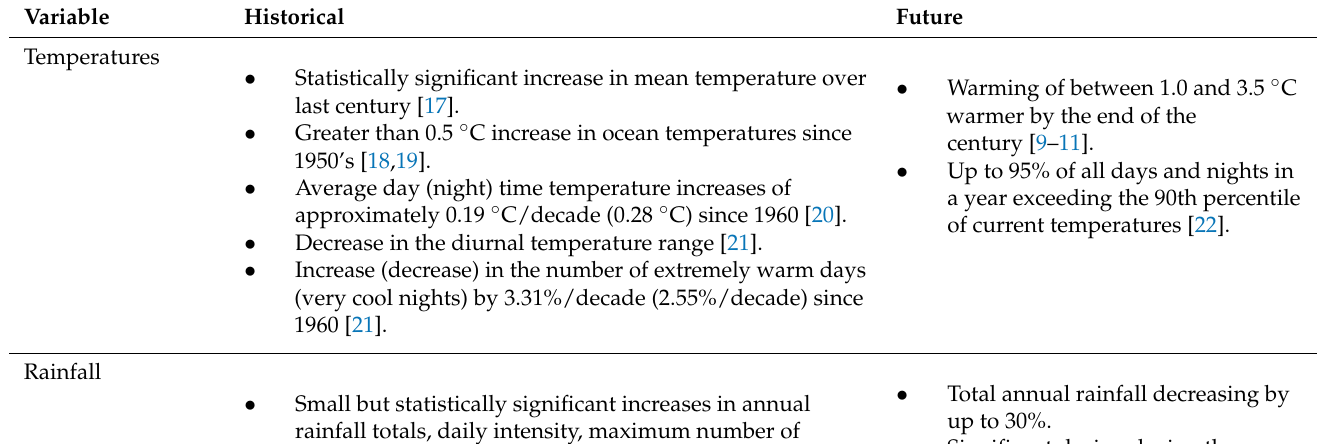
Table 1. Historical and future changes in Caribbean